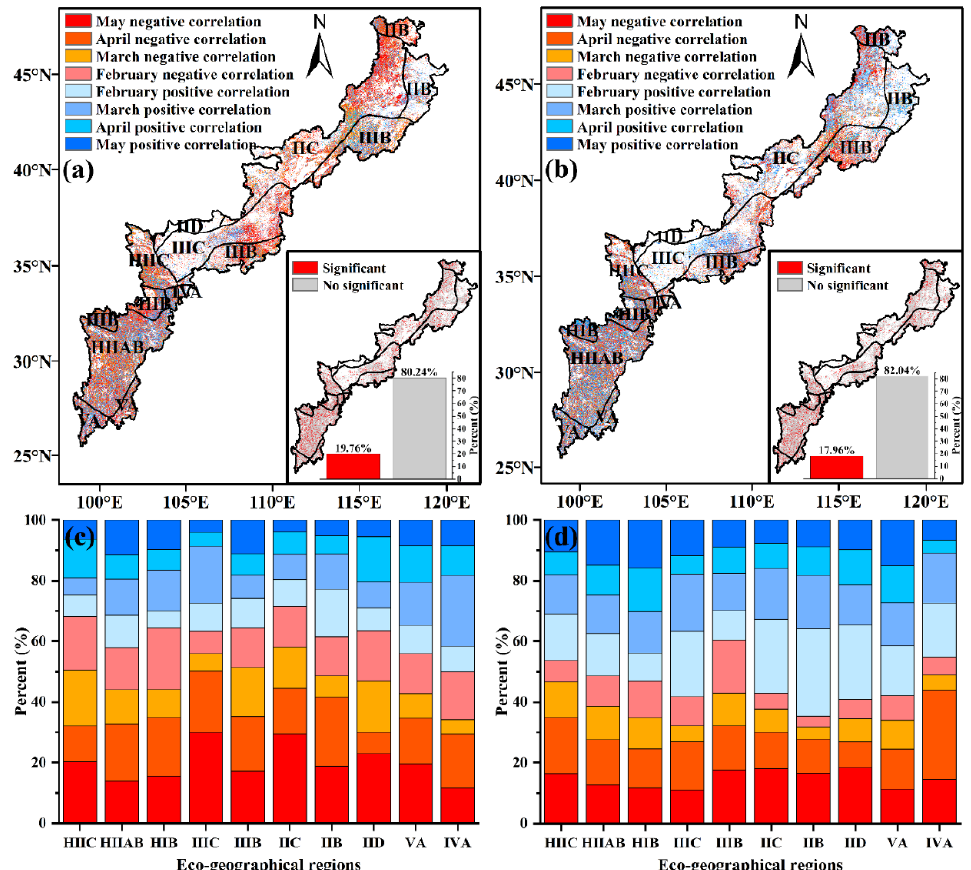
Figure 8. Spatial distribution of the correlations of the SOS with precipitation ( a ) and temperature ( b ) in the month with the greatest influence on it; The inset at the bottom right of each figure shows the pixels with a significance. ( c , d ) indicate the proportion of correlations between the SOS and the precipitation ( c ) and temperature ( d ) of the month with the greatest influence on it for different eco ‐ geographic regions, respectively.